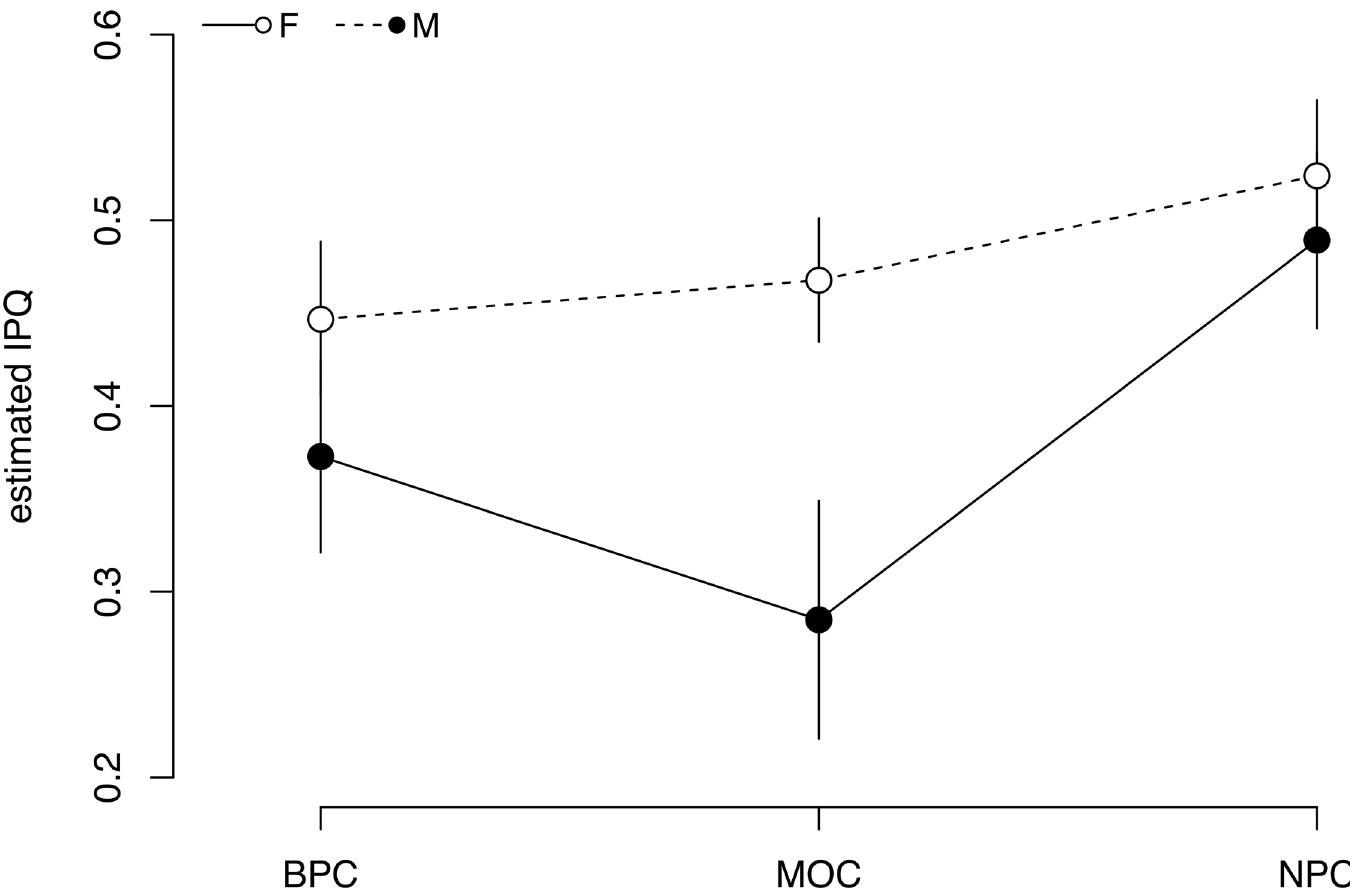
Fig 2. Mean (SE) index of patch quality (IPQ) for all within bout dives ( (cid:2) 3 m) by female and male murres across successive stages of the annual cycle. Values are GLMM model fits ± confidence intervals. Sample sizes provided in S1